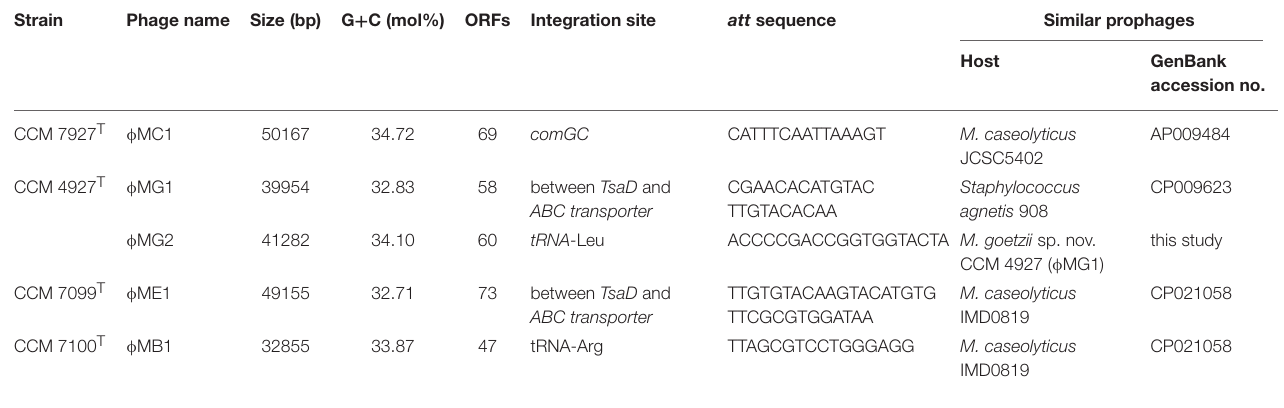
TABLE 3 | Prophages identified in genomes of human macrococci and their characteristics.